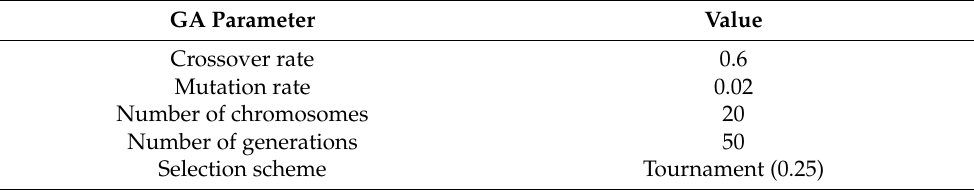
Table 2. Settings of GA parameters used in the proposed hybrid filter-GA feature selection method on all experimental